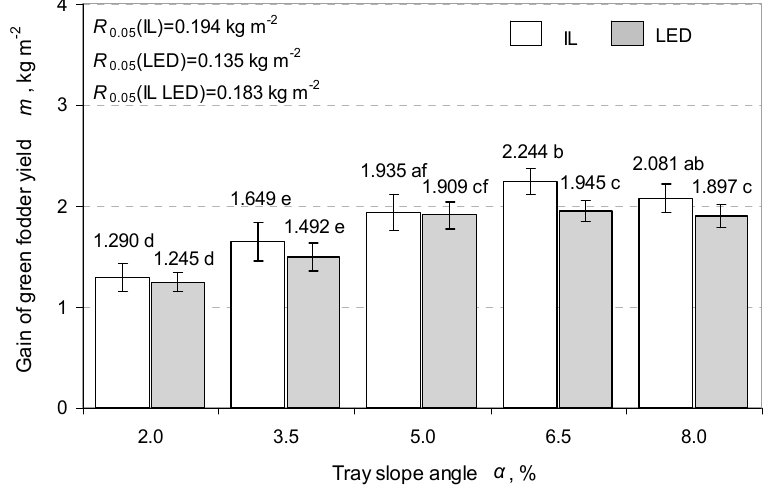
Figure 3. Average yield gain of green fodder ( m ) using di ff erent tray angles ( α ) and illuminations (IL or LED). Each vertical bar is 95 % confidence interval . Any two samples with a common letter are not significantly di ff erent ( p < 0.05), as assessed using the least significant di ff erence. By increasing the slope angle of the trays from 2.0% to 5.0%, there was an increase in fodder yield. A 6.5% slope angle of the trays significantly a ff ected the yield of the wheat fodder. The average mass − 2 − 2 gain at a slope angle of 6.5% was 2.24 ± 0.13 kg m using indoor lighting and 1.95 ± 0.10 kg m using LED. Notably, by increasing the slope angle of the growing trays to more than 6.5%, the quality of fodder started to decrease because the nutrient solution did not su ffi ciently nourish and moisten the − 2 seeds. With an 8.0% slope angle, the average daily weight gain was 2.08 ± 0.14 kg m with